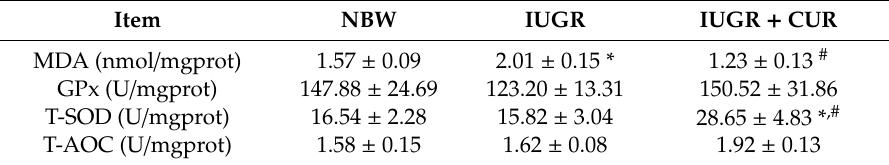
E ff ects of curcumin on antioxidant-related indexes: malondialdehyde (MDA), glutathione peroxide enzyme (GPx), total superoxide dismutase (T-SOD) and total antioxidant capacity (T-AOC) in jejunal mucosa. All values are